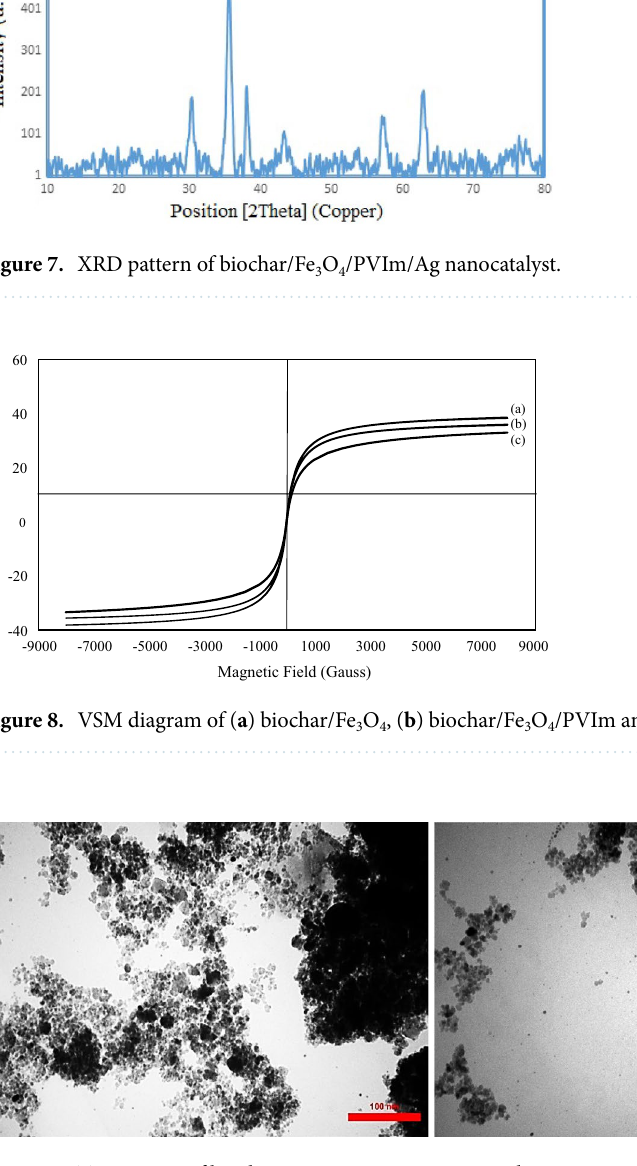
Figure 9. TEM image of biochar/Fe 3 O 4 /PVIm/Ag nanocatalyst.